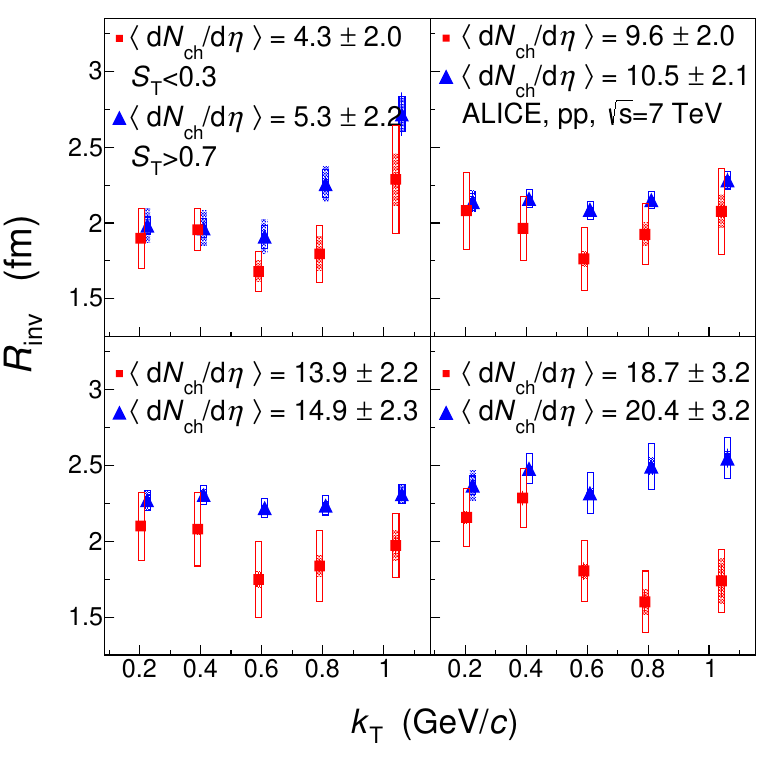
Figure 4 . Measured 1D source radii as a function of pair k T for spherical and jet-like events in pp p collisions at s = 7 TeV. Points are shifted horizontally for clarity. The vertical error bars represent the statistical uncertainties of the measurement, while the shaded and open boxes represent the uncorrelated and correlated systematic uncertainties,